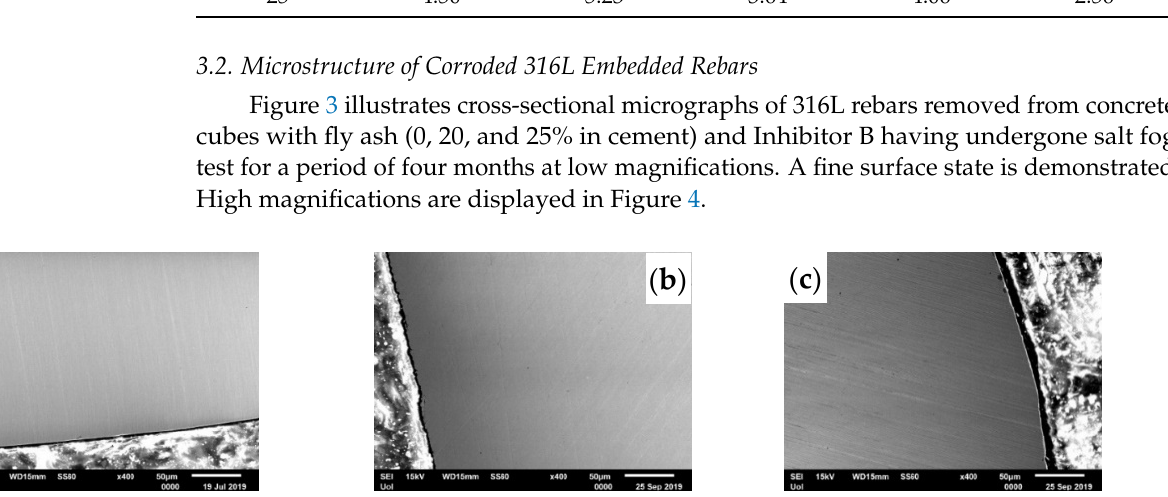
Elastic Modu- lus, %